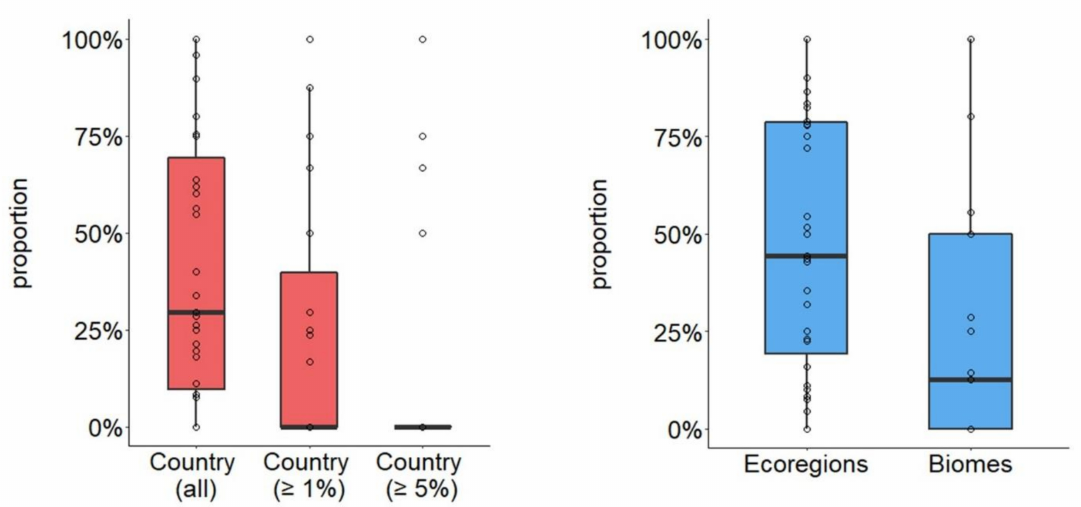
Figure 2. Boxplots showing the proportion of spatial units generated by a delineation method that were estimated to be too small to hold a minimum viable population of 1000 mature individuals, based on projecting the average density of mature individuals over the area (km 2 ) of the spatial unit. ( Left ): Proportion of spatial units that could never be considered Viable generated using countries as spatial unit delineations: fine divisions (all countries treated as separate spatial units); coarse divisions, ≥ 1% (all countries comprising at least 1% of the area of the baseline range treated as spatial units); and coarse divisions, ≥ 5% (all countries comprising at least 5% of the area of the baseline range treated as spatial units). ( Right ): Proportion of spatial units that could never be considered Viable generated using ecologically based spatial units: finer divisions (ecoregions used as spatial units) and coarser divisions (biomes used as spatial units).